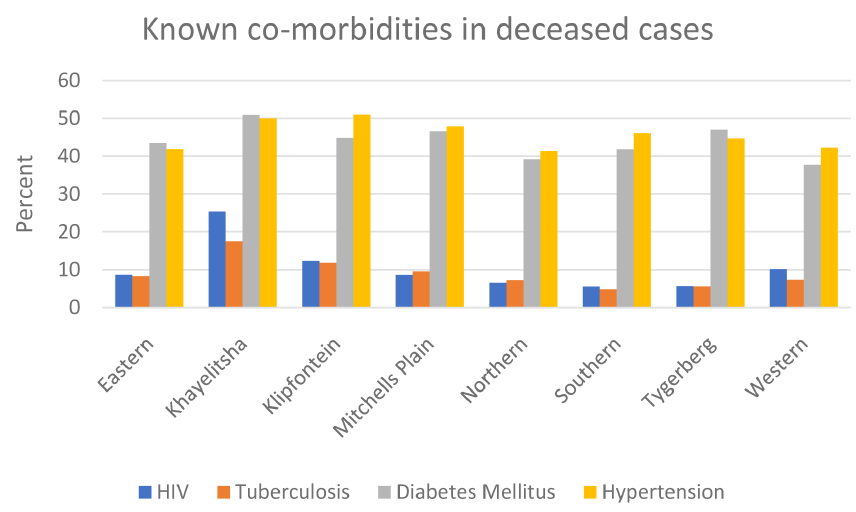
Figure 6. Known co-morbidities in deceased COVID-19 patients, by sub-district (note that tuberculosis includes both previous and current disease).